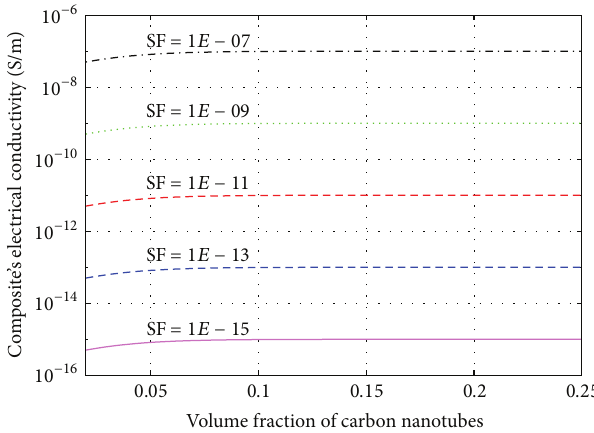
Figure 22: DC electrical conductivity of the nanocomposite when the midpoint of the percolation region’s width is varied (Sigmoidal function model).